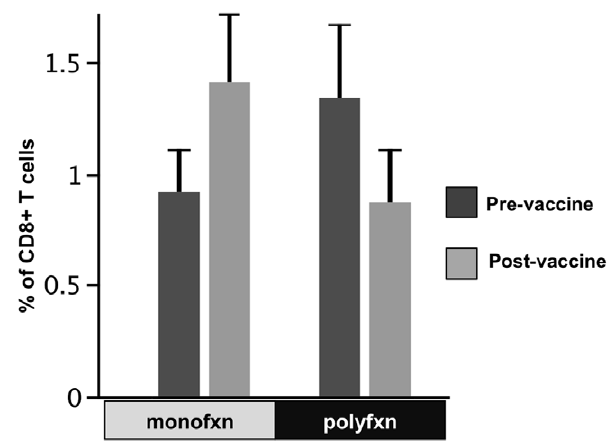
Figure 2. Percentages of CD8 + T cells with poly vs monofunc- tional responses before and after vaccination. Bars are the mean percentages ( + SE) of CD8 + T cells in paired pre- and post-vaccine samples secreting one (monofxn) or more than one (polyfxn) immune mediators (IFN c , TNF a , IL-2, MIP-1 b , and CD107a) in response to Gag peptide. (P=NS; N=7)